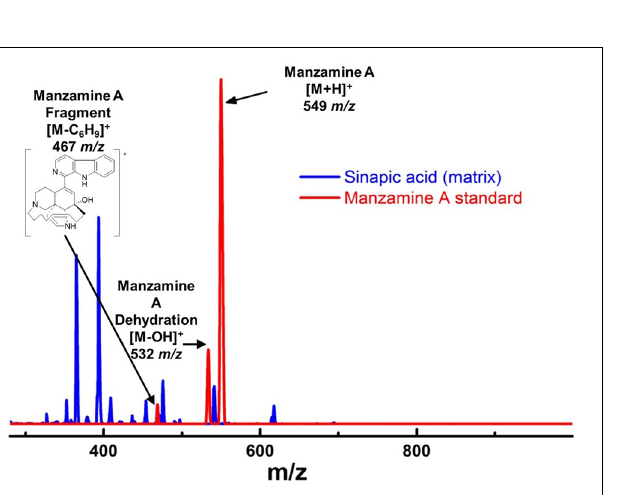
FIGURE 6 | Mass spectra of manzamine A standard vs. sinapic acid matrix on MALDI. There were challenges in choosing the appropriate matrix for MALDI MS imaging. After attempting several different MALDI matrixes, sinapic acid was chosen due to its ability to ionize manzamine A well, but without any interfering peaks. The fragment at 467 m/z was not used for imaging due to its low intensity and overlap with the matrix